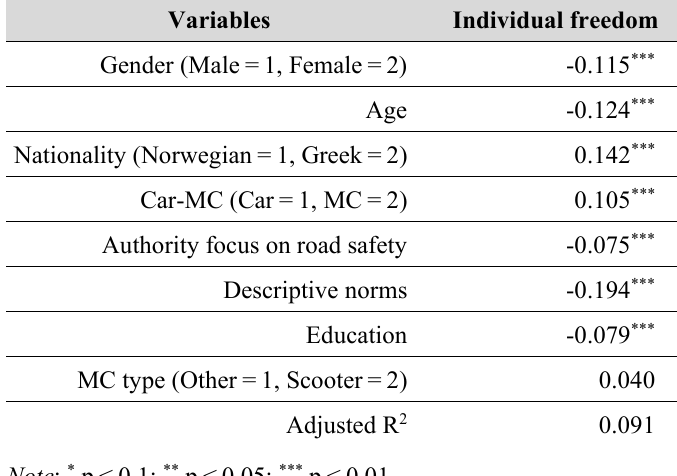
Table 3 Linear regression, beta coefficients; dependent variable: ‘ Freedom to take risk in traffic